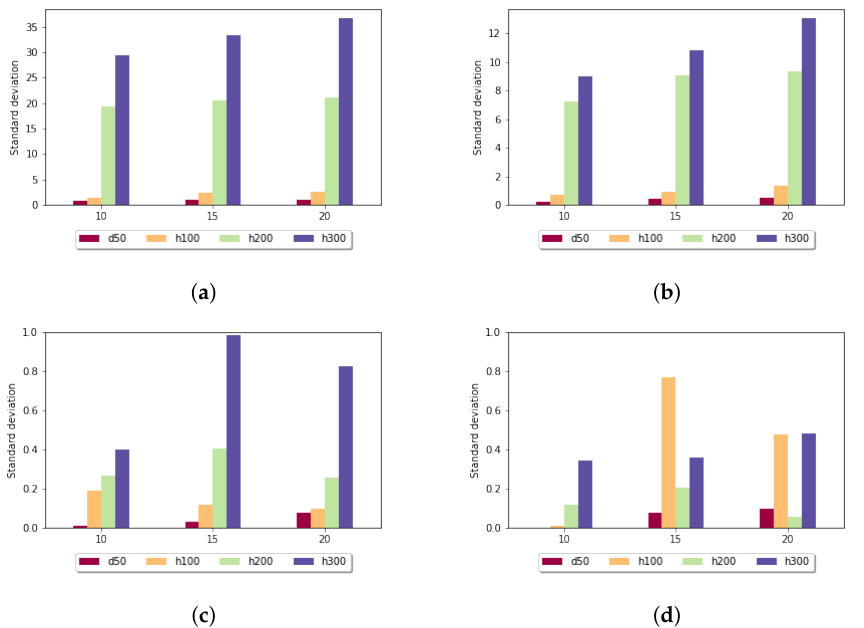
Figure 6. Standard deviation (y axis) depending on the size of the sample set (x axis) and length of the k-mers in the case of affine gap penalty: ( a ) k = 7; ( b ) k = 10; ( c ) k = 5; and ( d ) k =